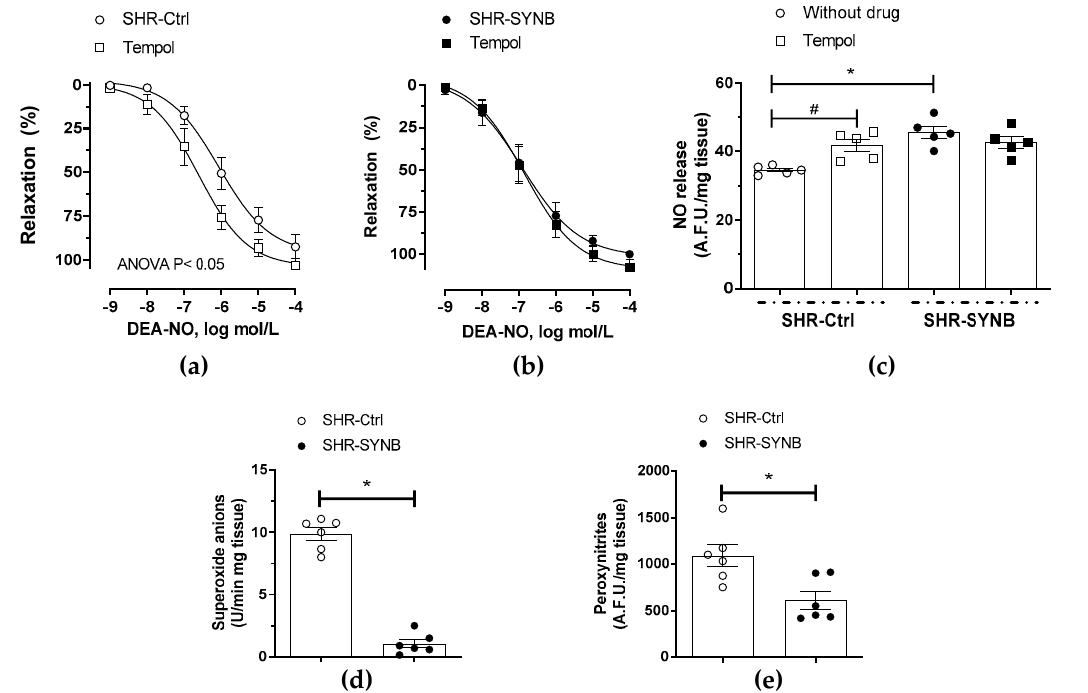
Figure 6. Effect of preincubation with 0.1 mmol/L tempol (a superoxide anion tempol) on the vasodilator response to NO donor DEA-NO in mesenteric segments from SHR-Ctrl ( a ) and SHR- SYNB ( b ). Results (mean ± S.E.M.) are expressed as a percentage of the previous tone elicited by noradrenaline. n = 6 segments from different animals in each experimental group. ( c ) Effect of preincubation with tempol on EFS-induced NO release in mesenteric arteries from SHR-Ctrl and SHR-SYNB. Data (Mean ± S.E.M.) are expressed as arbitrary fluorescence units/mg tissue. * p < 0.05 SHR-Ctrl vs. SHR-SYNB (Student´s t -test). # p < 0.05 conditions without tempol vs. conditions with tempol in each group (Student´s t -test). n = 5 segments in each experimental group. ( d ) Superoxide anion formation in mesenteric segments from SHR-Ctrl and SHR-SYNB. Results (mean ± S.E.M.) are expressed as chemiluminiscence units (U)/min mg tissue. n = 6 segments in each group. p < 0.05 (Student´s t -test). ( e ) EFS-induced peroxynitrite release in mesenteric arteries from SHR-Ctrl and SHR-SYNB. Data (Mean ± S.E.M.) are expressed as arbitrary fluorescence units/mg tissue. n = 6 segments in each group * p < 0.05 (Student´s t -test).